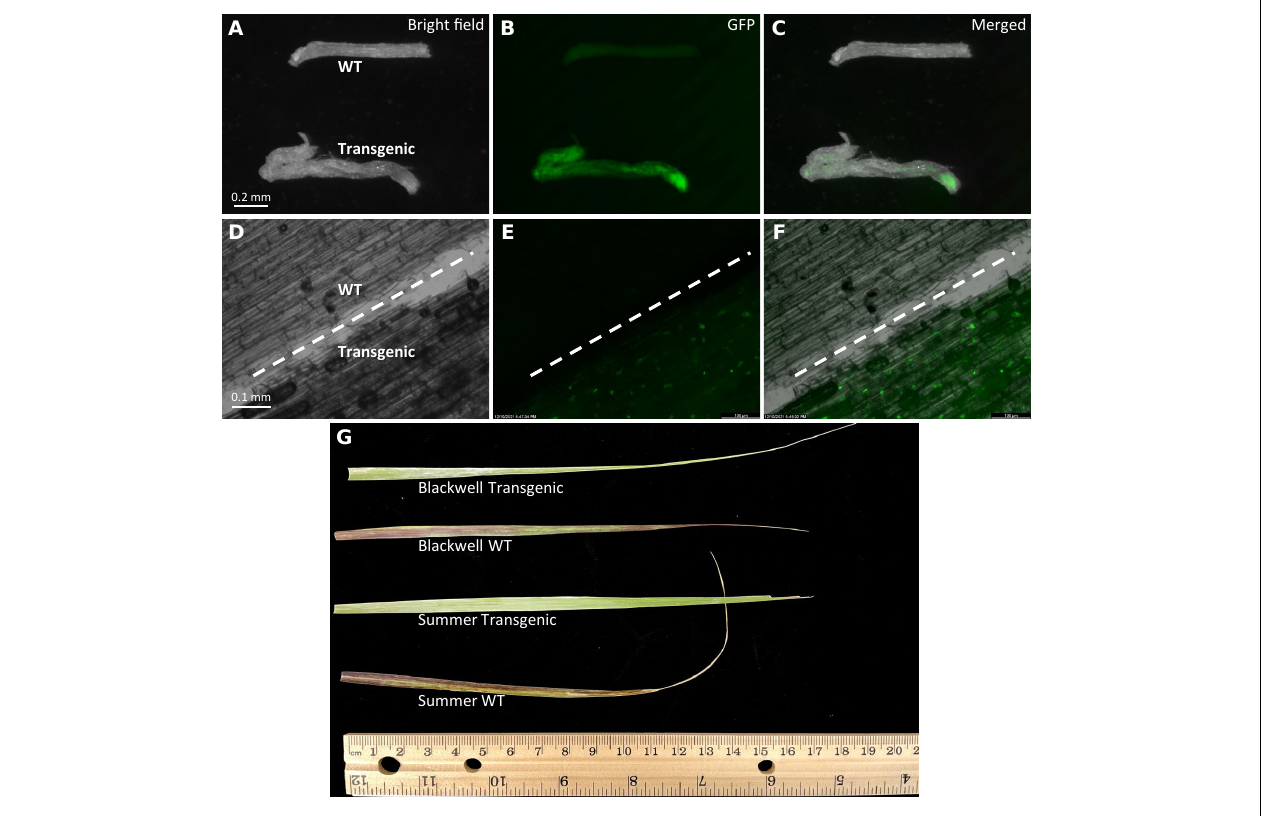
FIGURE 5 | Phenotypic characterization of transgenic plants. (A–C) Observation of GFP signals with an Olympus florescent stereomicroscope in roots of 10-week-old transgenic plant, S8 of ‘Summer’ (Transgenic) and the wild type (WT) of similar age under either bright field (A) , GFP (B) , or merged (C) . (D–F) Observation of GFP signals with a Zeiss upright microscope in both WT and transgenic roots under either bright field (A) , GFP (B) or merged (C) . The white dashed line in each image separates the wild type root (upper left) from the transgenic root (lower right). (G) Leaf response to herbicide injury. Herbicide Alligare Mojave 70 EG (active ingredient imazapyr at 7.78%) was applied twice at a concentration of 0.9 g/mL with a 5-day interval to newly expanded leaves of the wild type and putative transgenic plants of Summer and Blackwell. Image was taken at the 7th day after the first painting.